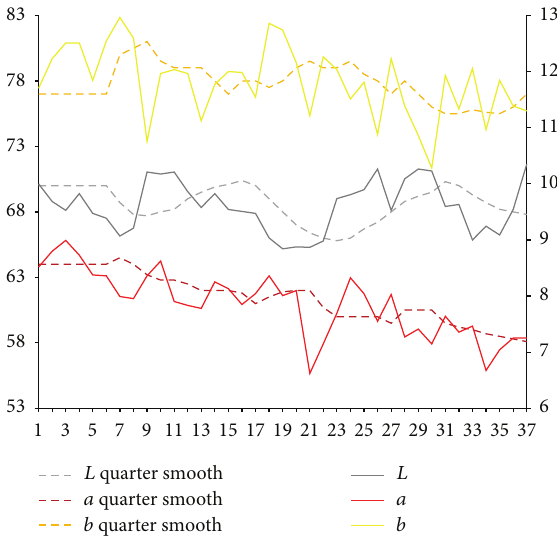
Figure 9: Lab value changing trend of right cheek.